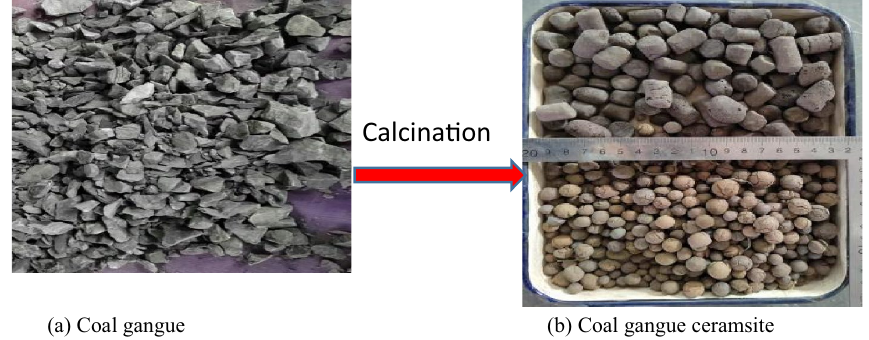
Figure 1. Change of ma croscopic morphologies.